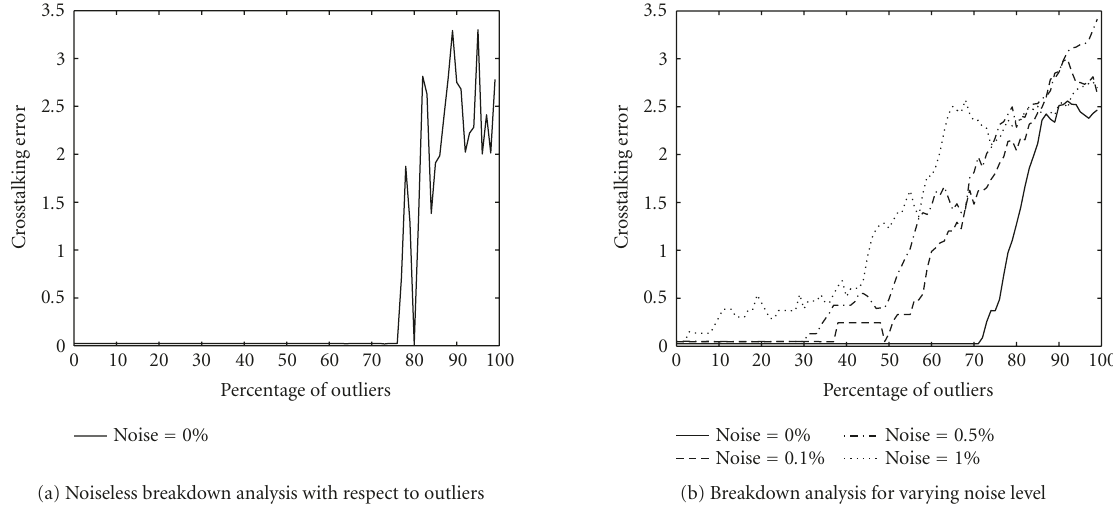
Figure 5: Performance of Hough SCA with increasing number of outliers. Plotted is the percentage of outliers in the source data versus the matrix recovery performance (measured by the generalized crosstalking error). For each 1%-step one calculation was performed; in (b) the plots have been smoothed by taking average over ten 1%-steps. In the no-noise case 360 bins were used, 180 bins in all other cases.